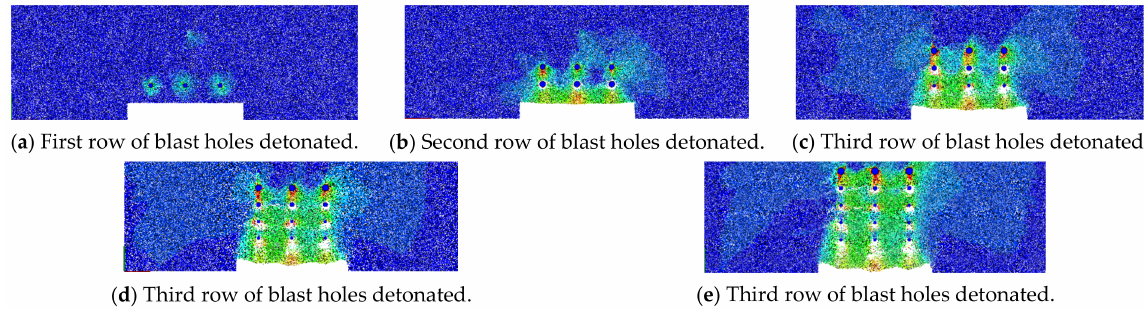
Figure 7. Differential blasting process